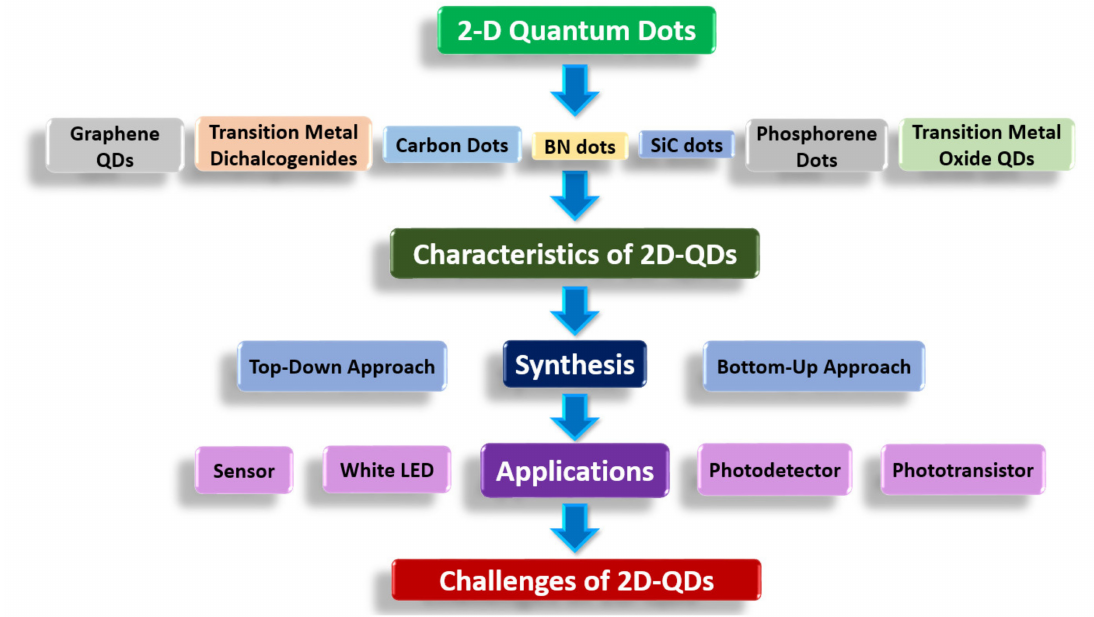
Figure 4. Overview of the present 2-D quantum dots